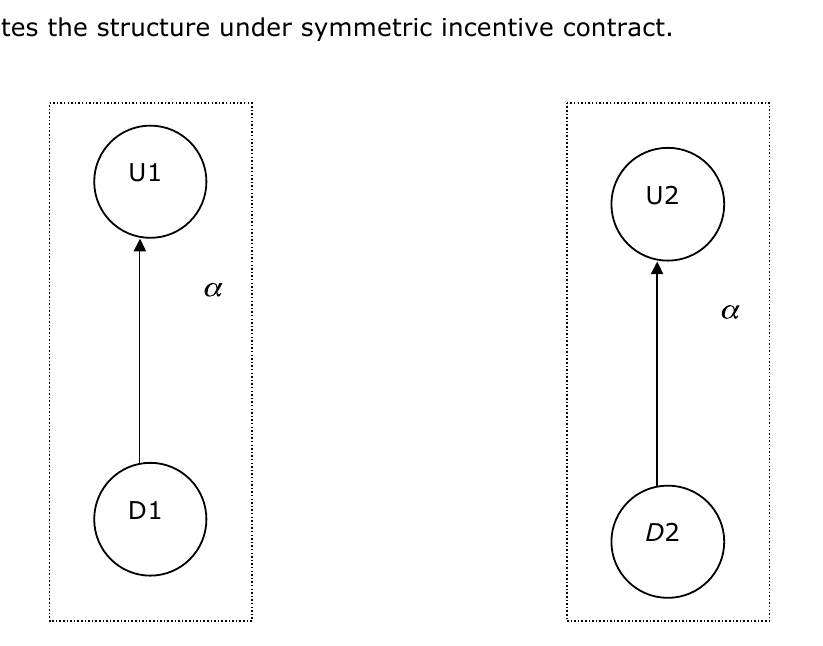
Figure 4. “Competition under symmetric incentive contract